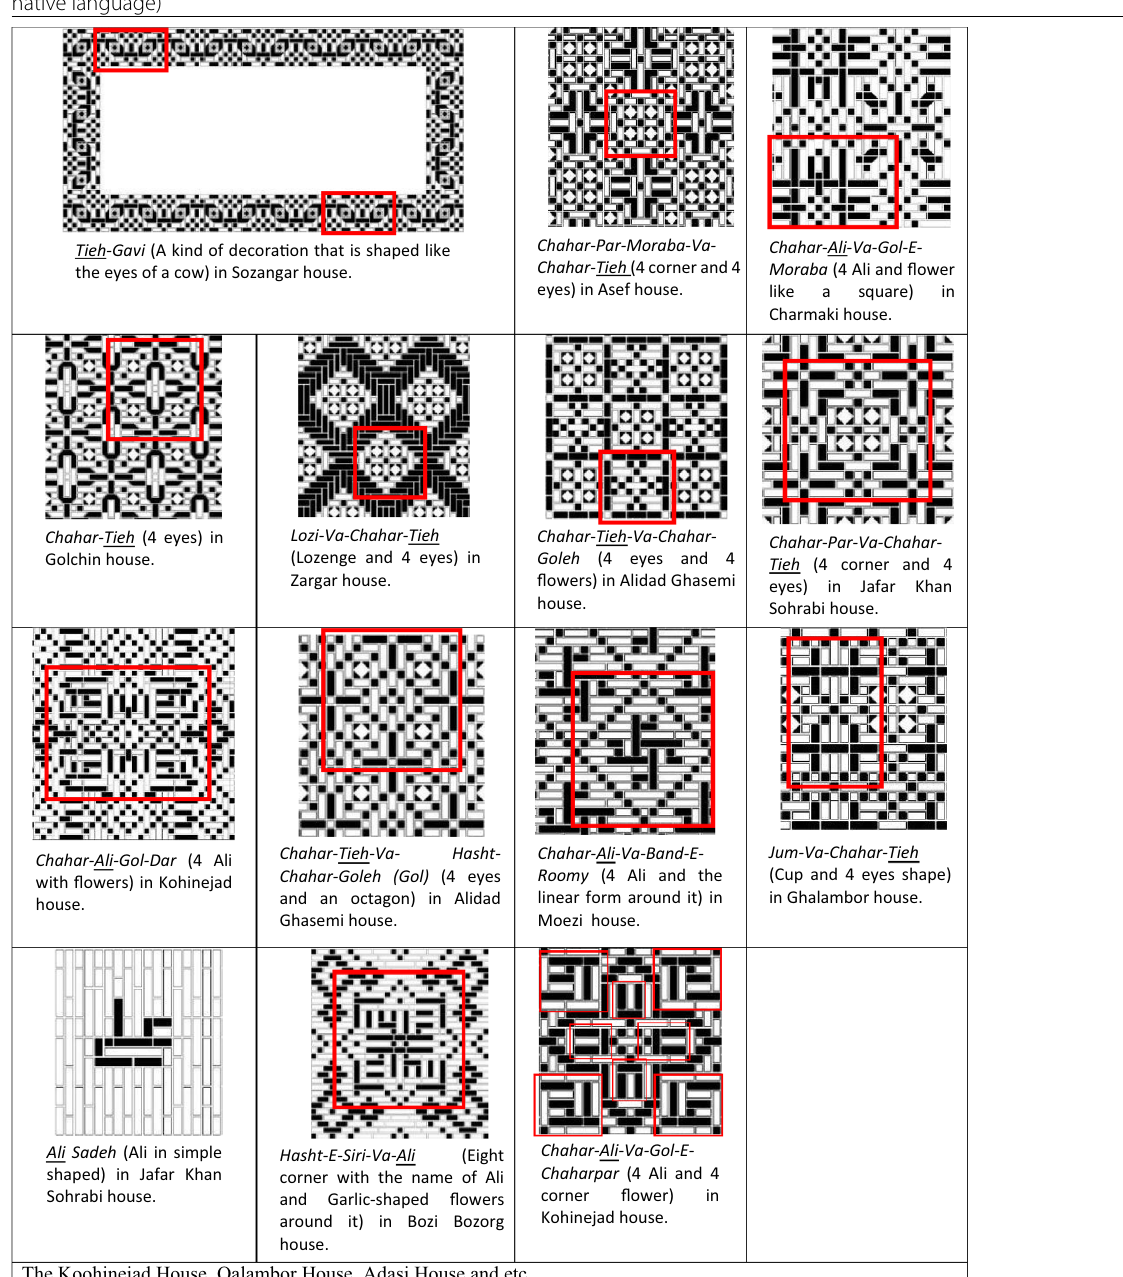
Table 5 The Xowun names in religious and belief motifs (the name of the brick decoration is derived from architectural terms in the native